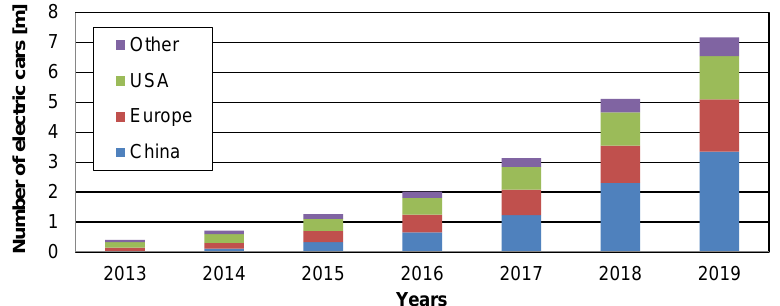
Figure 1. Increasing number of electric and plug-in hybrid vehicles between 2013 and 2019 [2].